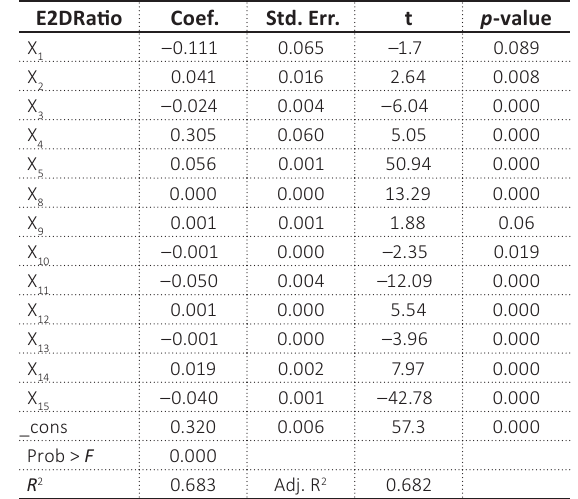
Table 6. Regression analysis of all selected